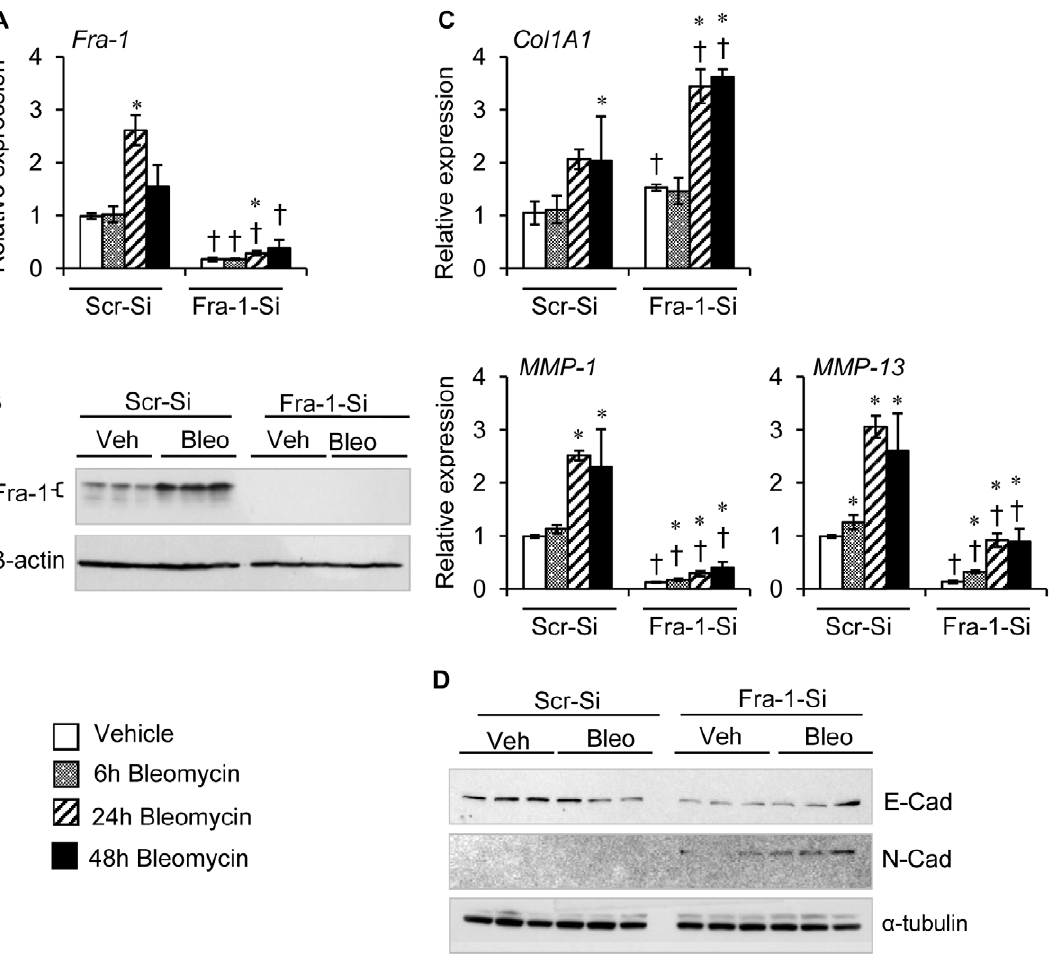
Figure 8. The effects of Fra-1 knockdown on bleomycin-induced mesenchymal marker, and fibrotic and anti-fibrotic gene expression in AECs. Cells were treated with vehicle or bleomycin (5 mU/ml) for different time points, and harvested for RNA and protein isolation. A: Expression of Fra-1 analyzed by qRT-PCR. B: Fra-1 expression was analyzed by western blot analysis using b -actin as reference. C: Col1A1 , MMP-1 and MMP-13 expression analyzed by qRT-PCR. D: E-cad, N-Cad, and a -tubulin detected by immunoblot in AECs treated with vehicle or bleomycin for 24 hours. Results are mean 6 SD, representative of 2 separate experiments performed in triplicate per group. P , 0.05, PBS vs bleomycin; { P , 0,05, Scr-si-RNA vs Fra-1-SiRNA cells at corresponding time